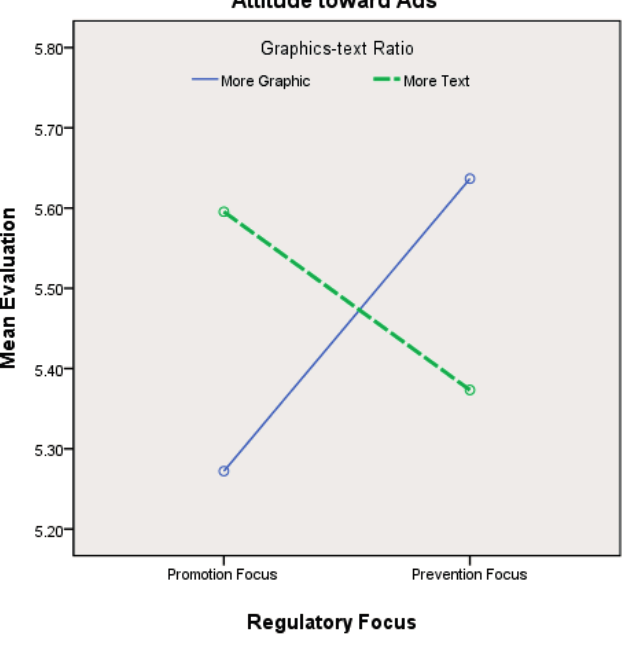
Figure 6. Interaction effects between regulatory focus and the graphics-text ratio on attitude toward